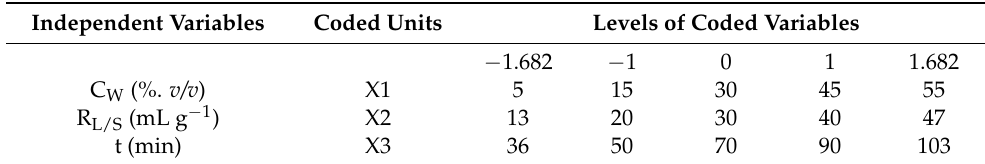
Table 1. Experimental values and coded levels of the independent variables used for the central composite design.